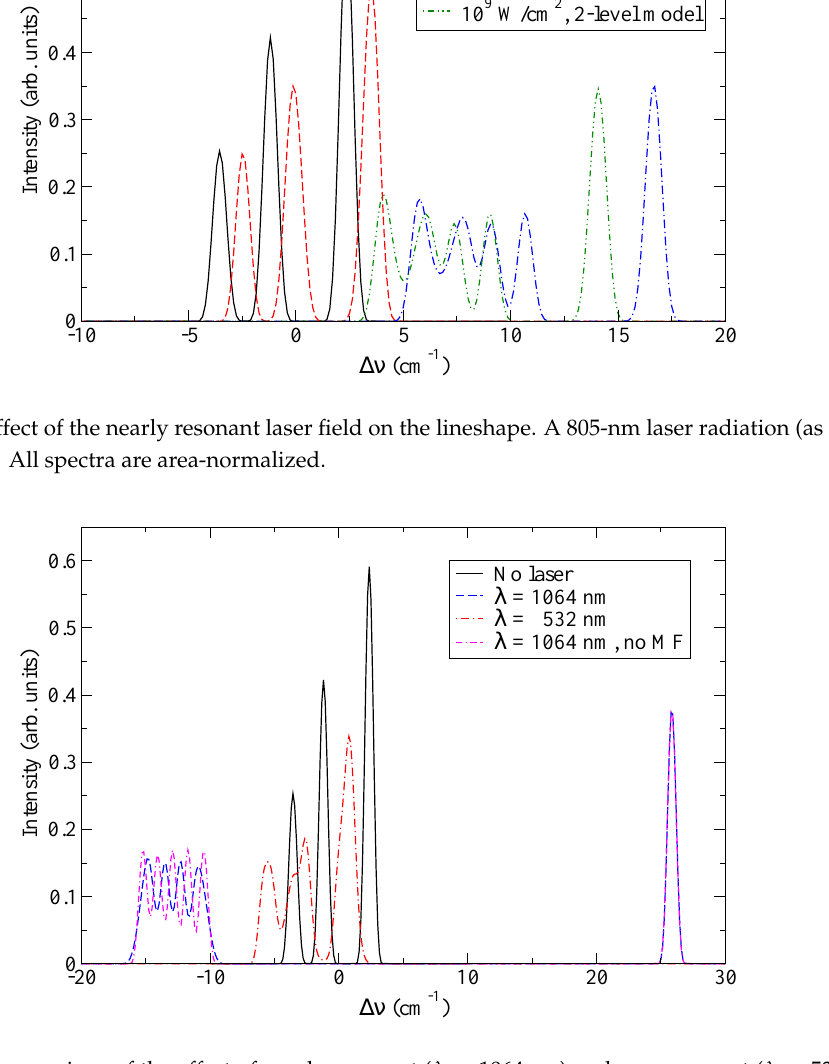
Figure 3. Comparison of the effect of nearly resonant ( λ = 1064nm) and non-resonant ( λ = 532nm) laser fields on the lineshape. Laser irradiation intensity of 10 10 W/cm 2 is assumed. All spectra are